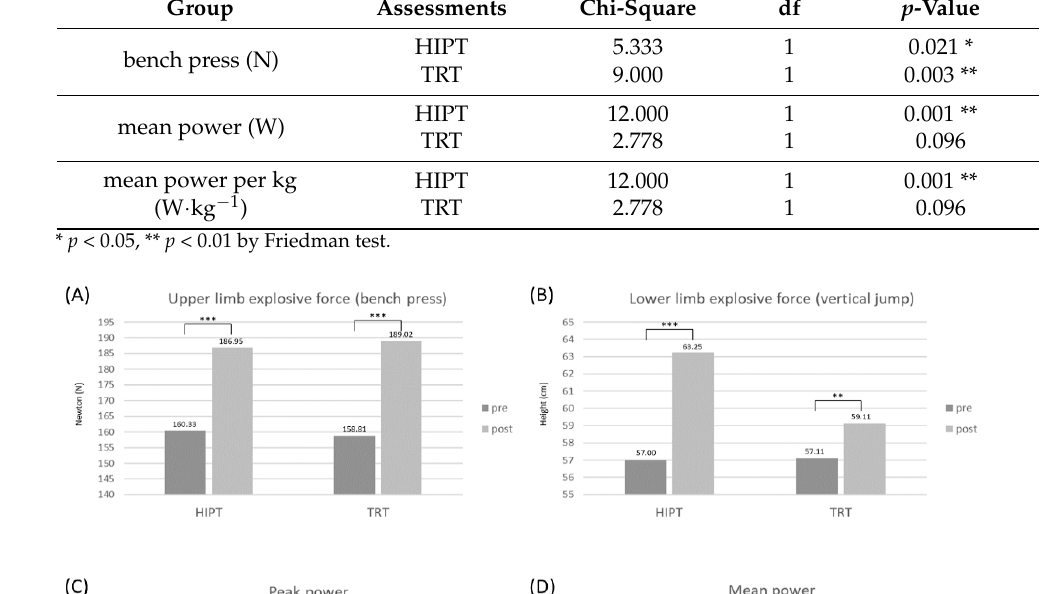
Table 3. The differences in bench press and mean power between pretest and post-test.